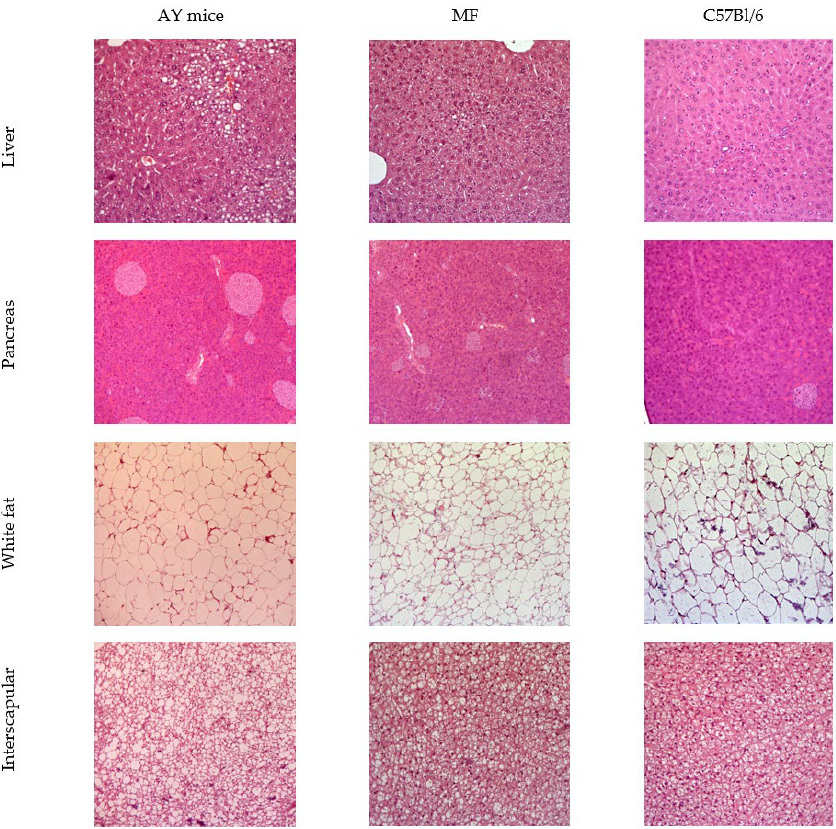
Figure 8. Micrographs of sections of the liver, pancreas, white and brown interscapular fat at the end of the experiment. In case of C57Bl/6 mice, gonadal white fat was investigated. Stained with hematoxylin and eosin. Magnification—liver × 200, other ×